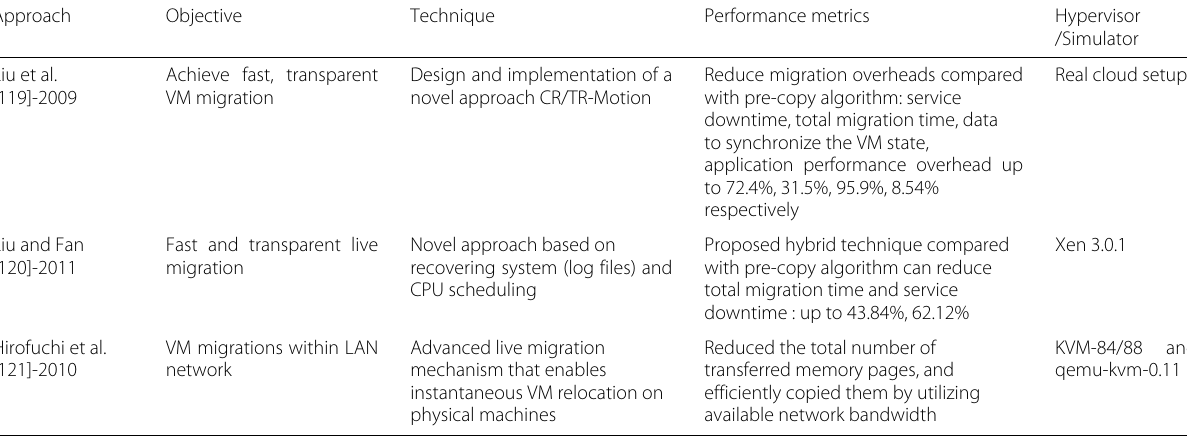
Table 13 Comparison of Page fault aware VM migration approaches